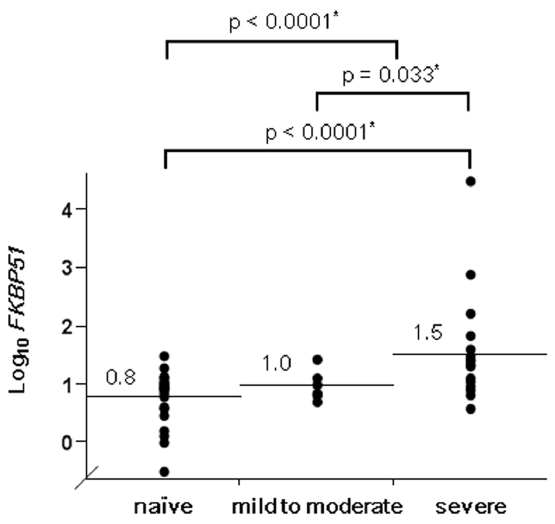
Figure 1. FKBP51 levels in induced sputum cells in patients with asthma. FKBP51 mRNA levels normalized to b 2 microglobulin mRNA levels in induced sputum cells became progressively higher from steroid-naı¨ve asthmatic patients (naı¨ve, n=31), to mild to moderate asthmatic patients on inhaled corticosteroid (mild to moderate, n=6), and then to severe persistent asthmatic patients on inhaled cortico- steroid (severe, n=22) (p , 0.0001 by the Kruskal-Wallis test). *Signifi- cant by the Wilcoxon rank-sum test. Values and bars represent means.